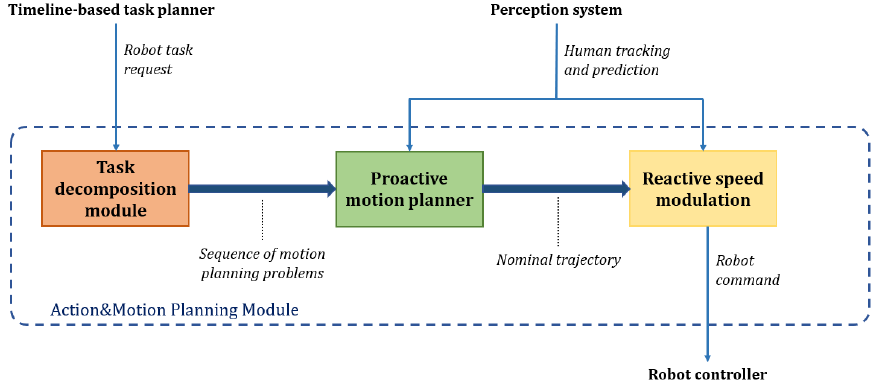
Figure 5. Action and Motion Planning